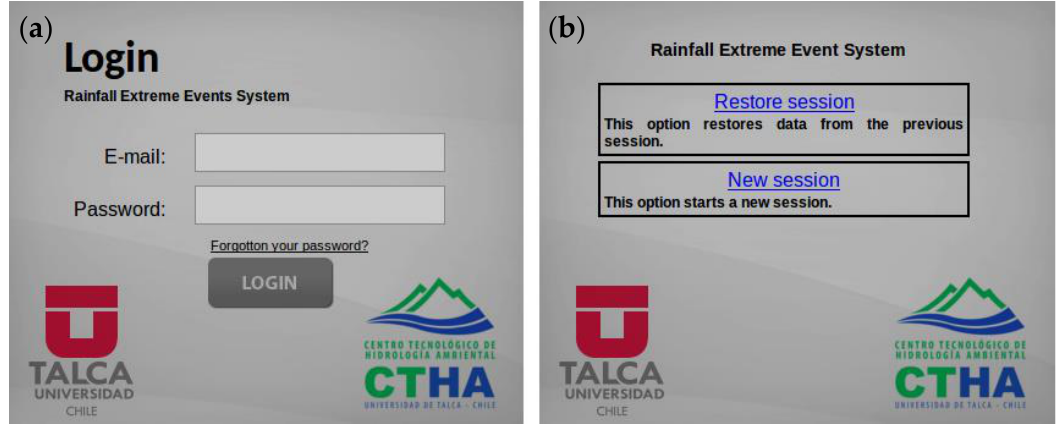
Figure 6. Graphical user interface (GUI) for the creation of new a user account in WEBSE IDF. ( a ) The login screen, ( b ) Restore previous session option.